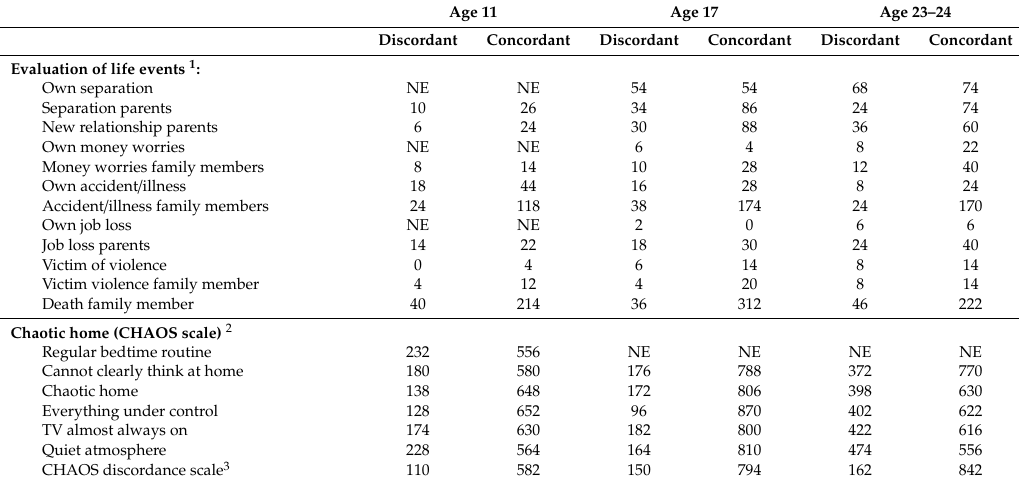
Table 2. Salience of living conditions and evaluation of life events (based on valid information for both twins only) (N).